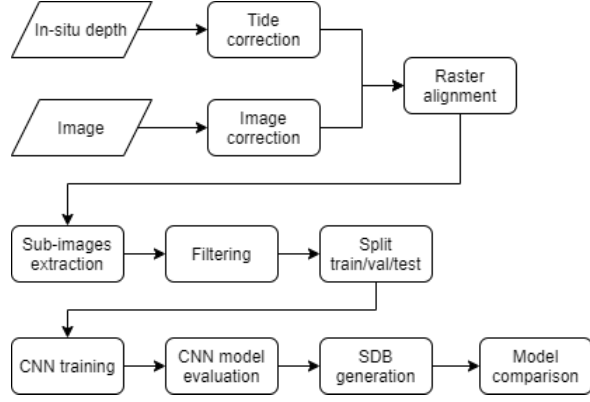
Figure 3. General workflow of this study.